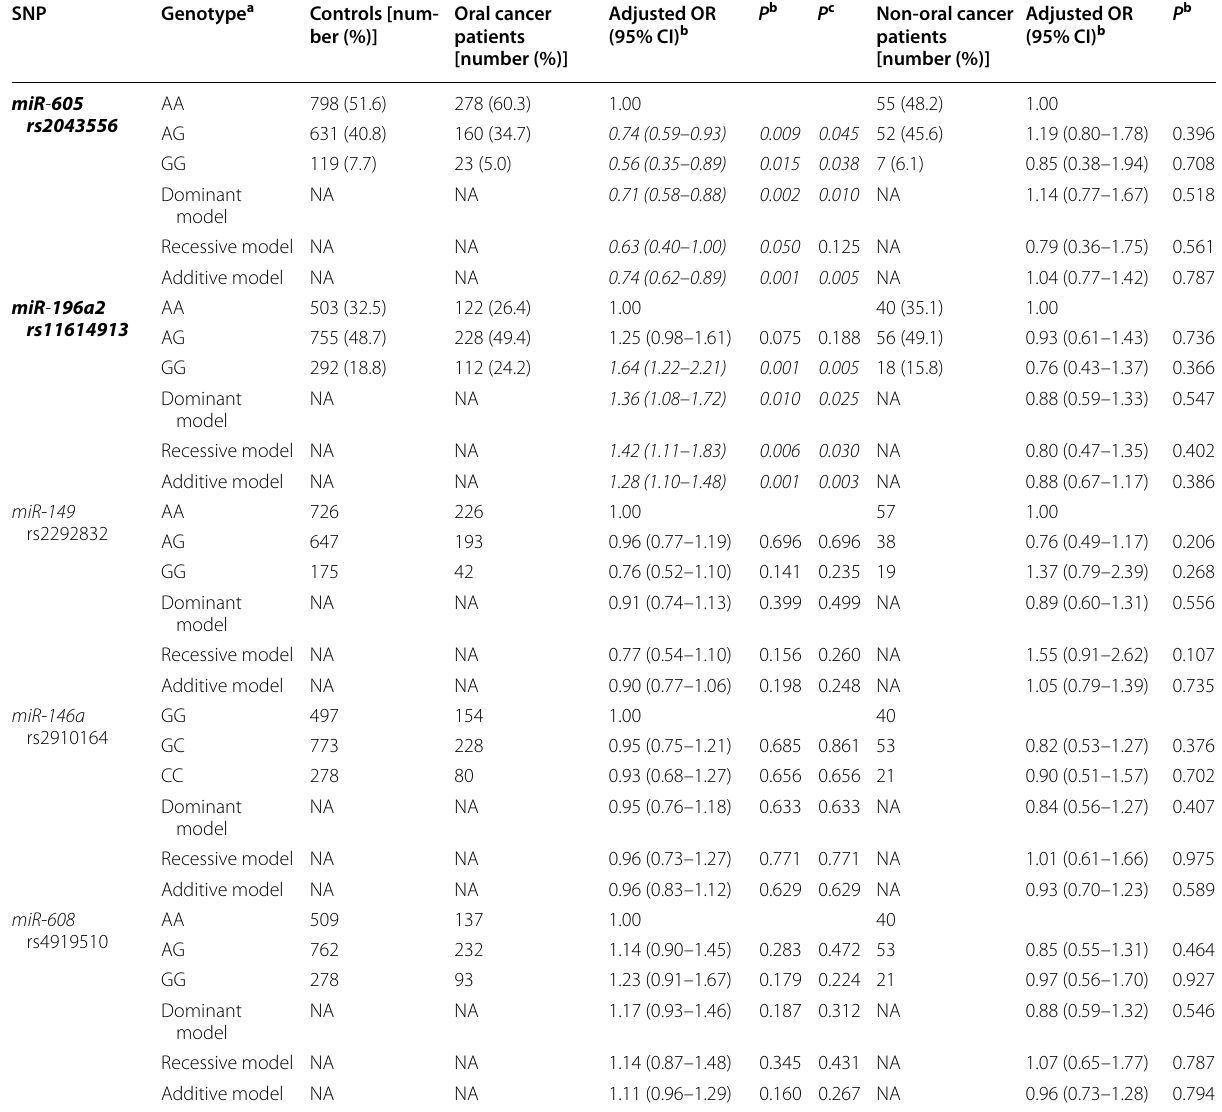
Table 3 Logistic regression analysis for associations between selected SNPs and HNSCC